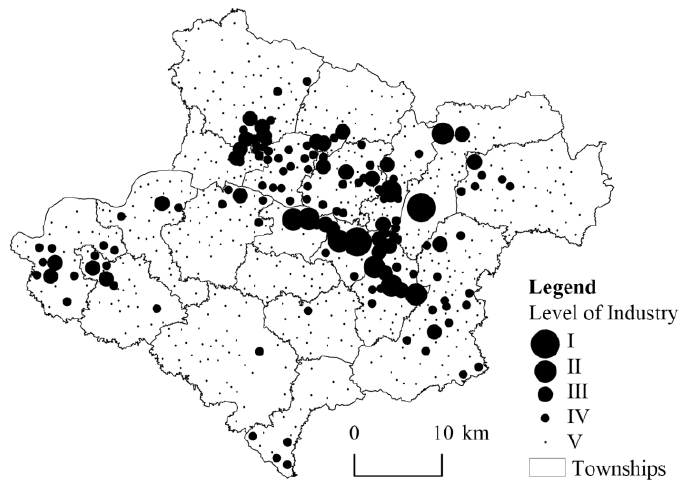
Figure 5. Location of villages with different levels of industry.